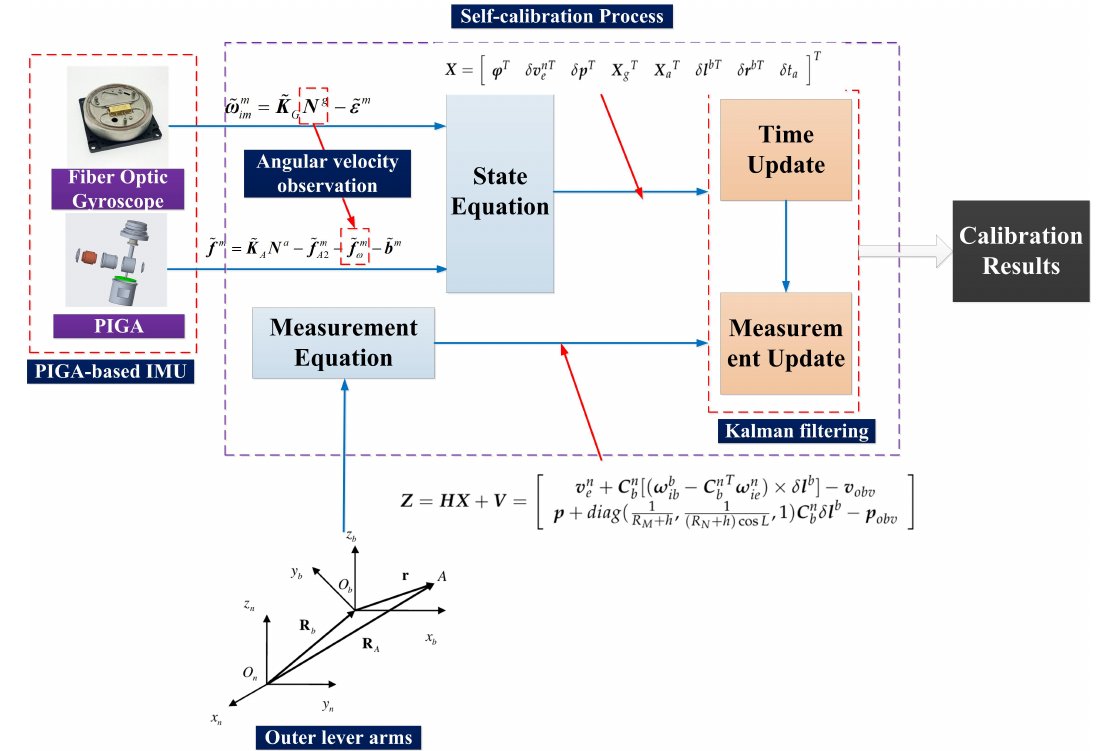
Figure 4. Self-calibration process utilizing angular velocity